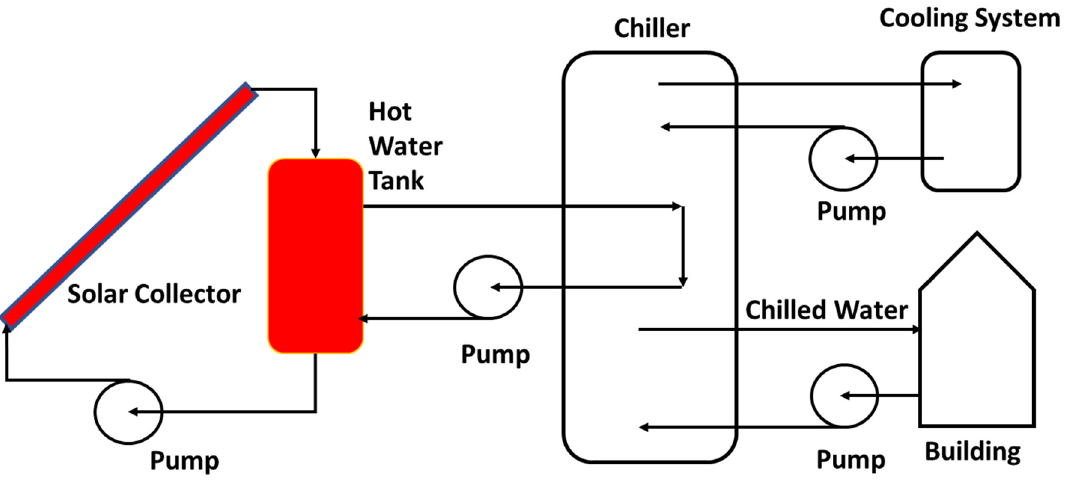
Figure 8. Schematic diagram of solar cooling with an absorption refrigeration Figure 8 . Schematic diagram of solar cooling with an absorption refrigeration cycle.